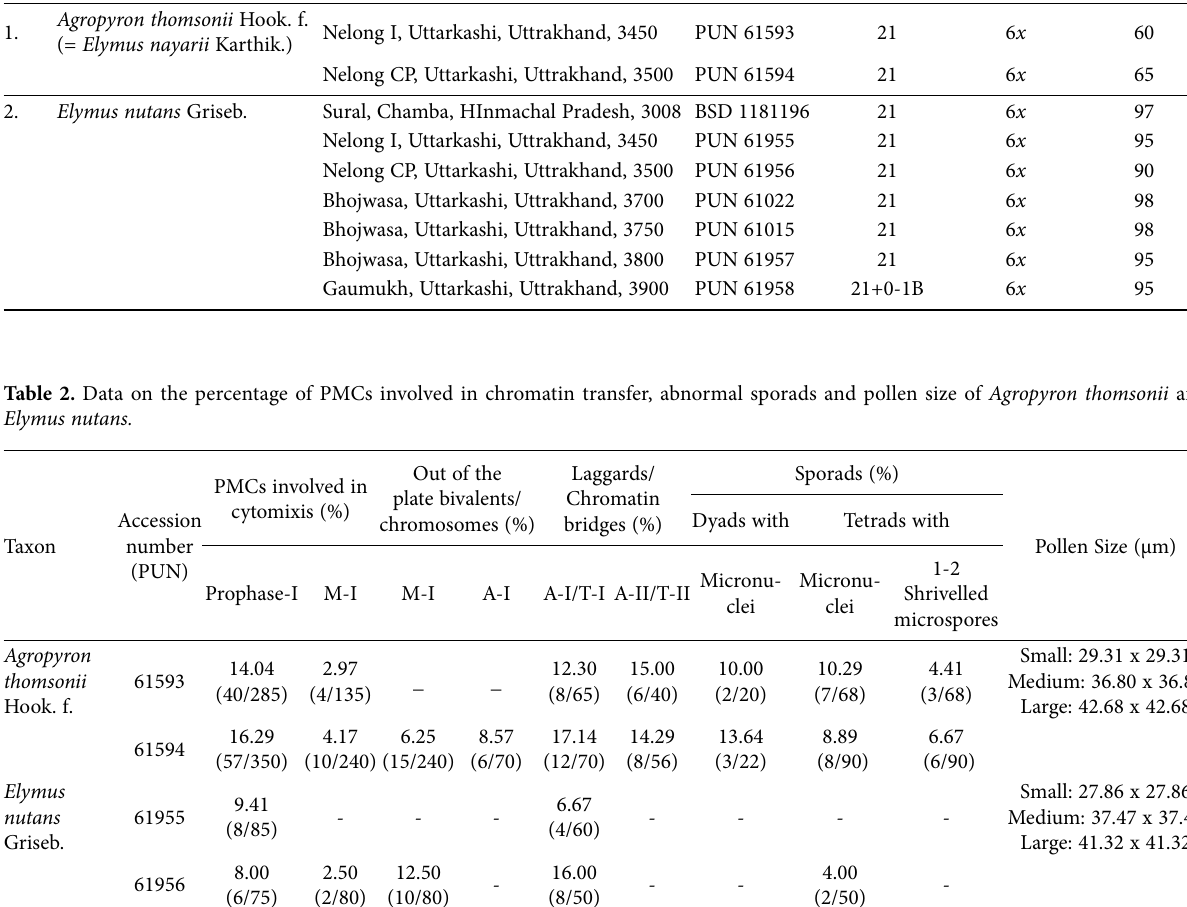
Table 1. Information on taxon, locality of collection with altitude, accession number/s, meiotic chromosome number, ploidy level, pollen fertility percentage of the cytologically investigated taxa.